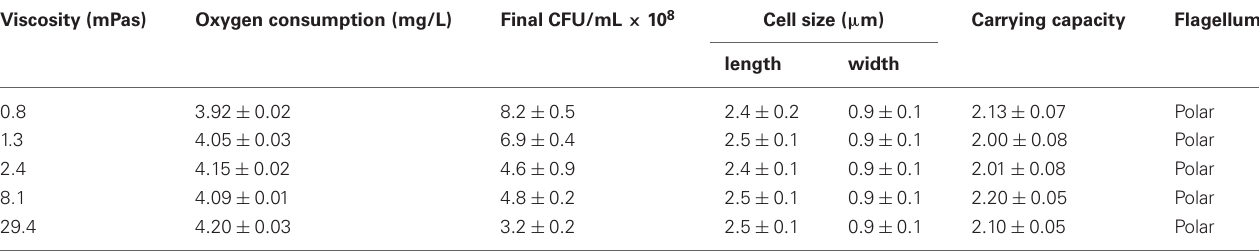
Table 1 | Oxygen consumption, CFU values, cell size, carrying capacity, and the type of flagellum for V. ruber grown at different viscosities. Viscosity (mPas) Oxygen consumption (mg/L) Cell size ( µ m) Carrying capacity Flagellum length